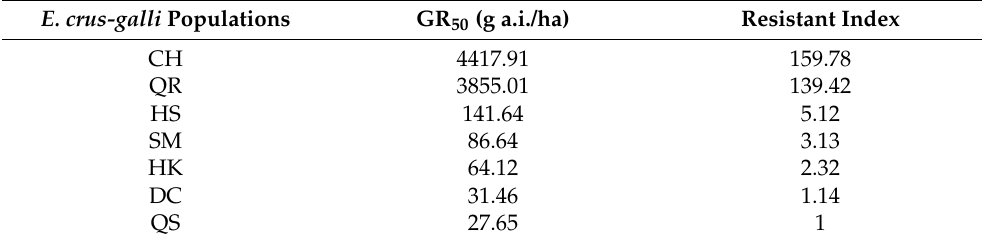
Table 1. Quinclorac dose–response analyses for E. crus-galli